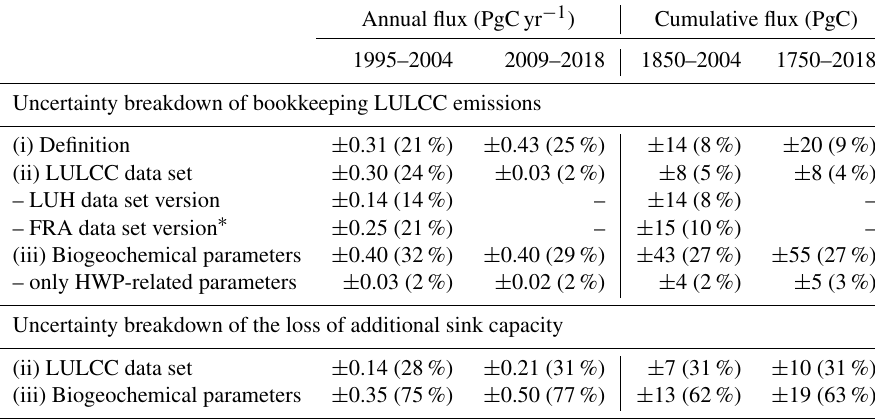
Table 3. Uncertainty sources in our estimates of bookkeeping LULCC emissions and LASC expressed as the debiased standard deviation (1 σ ) and the coefficient of variation (CV; in